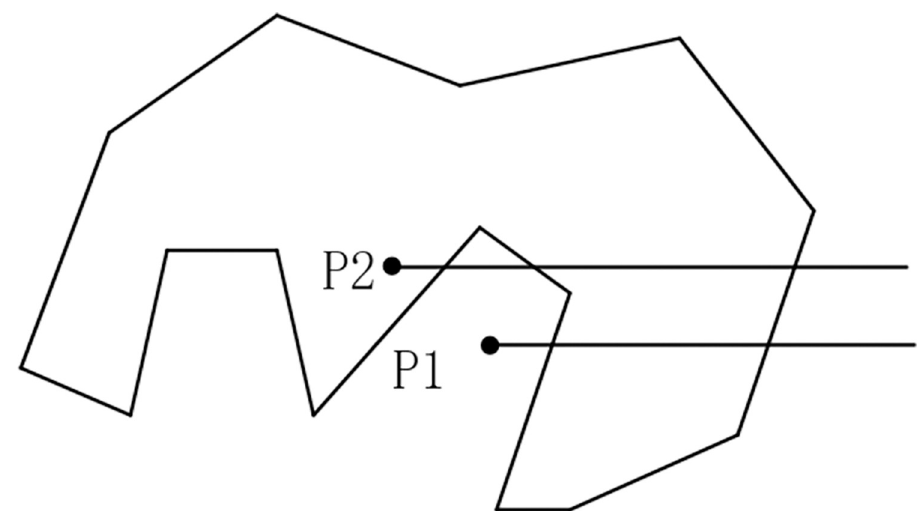
Fig 5. Diagram of the location relationship between points and